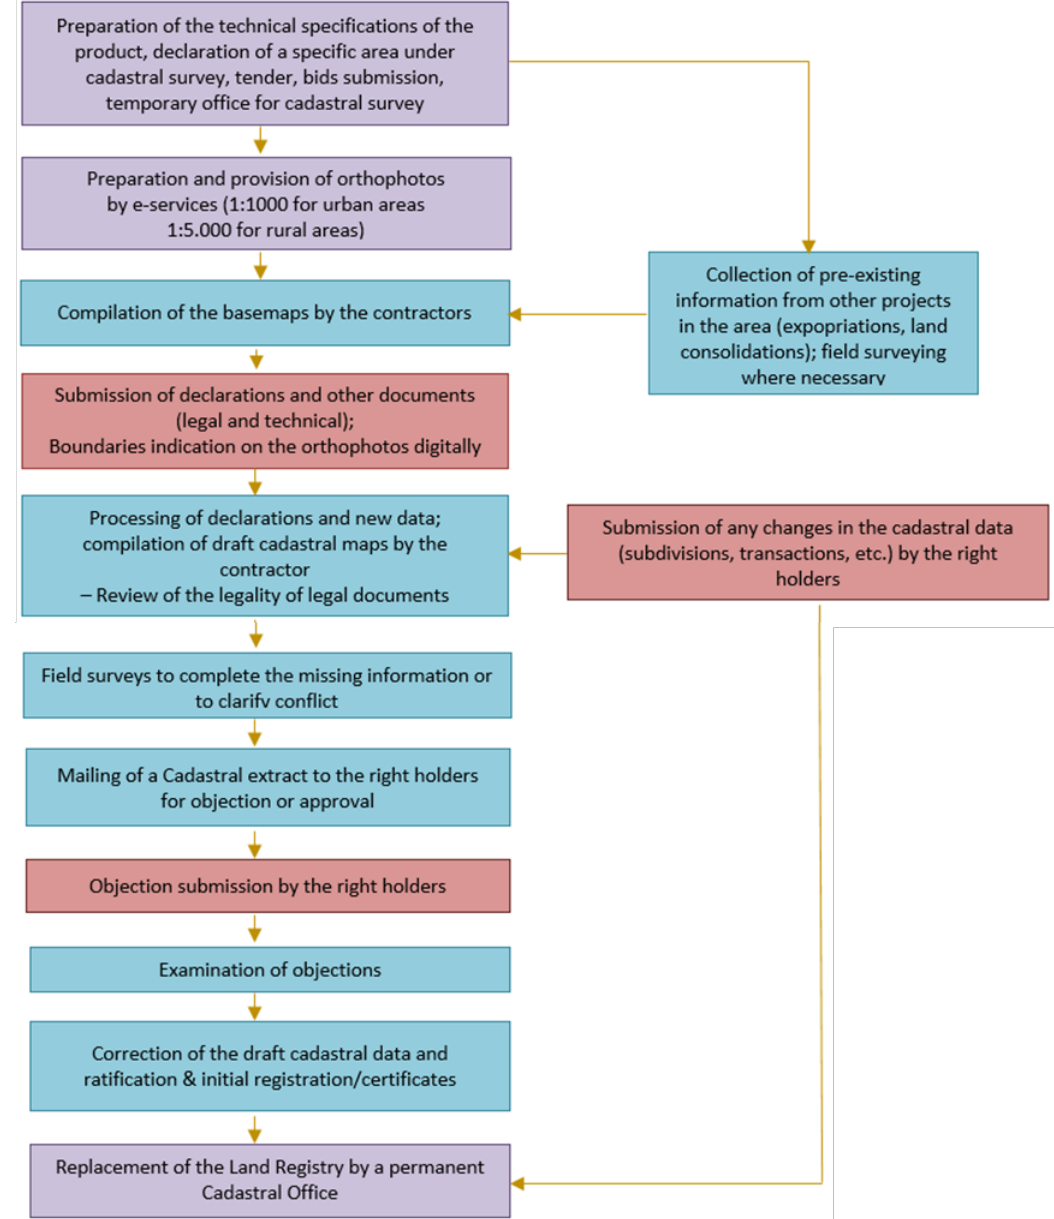
Figure 2. Main stages of the official procedure of the Hellenic Cadastre Survey (stages in purple color depict NCMA actions; stages in blue color depict cadastral surveyors’ actions; stages in pink color depict right holders’ actions).